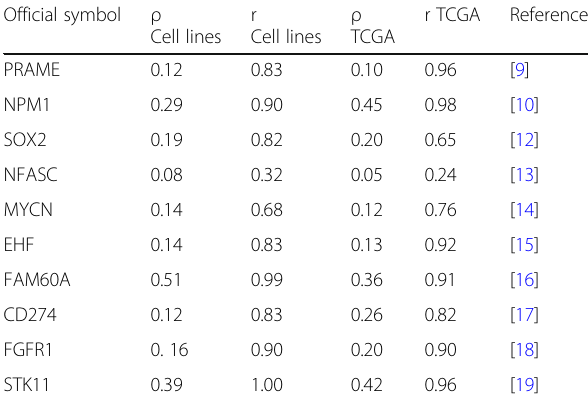
Table 1 Correlation validation of genes with a significant correlation between CNV and differential gene expression in literature Official